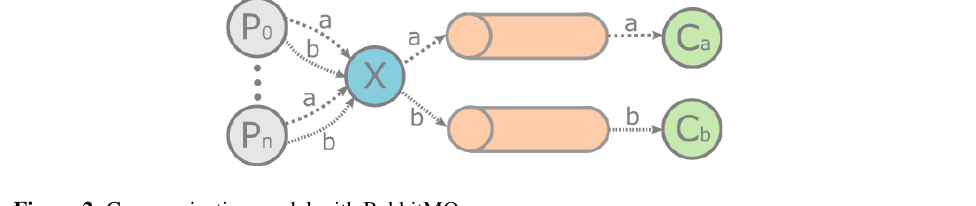
Figure 2. Communication model with